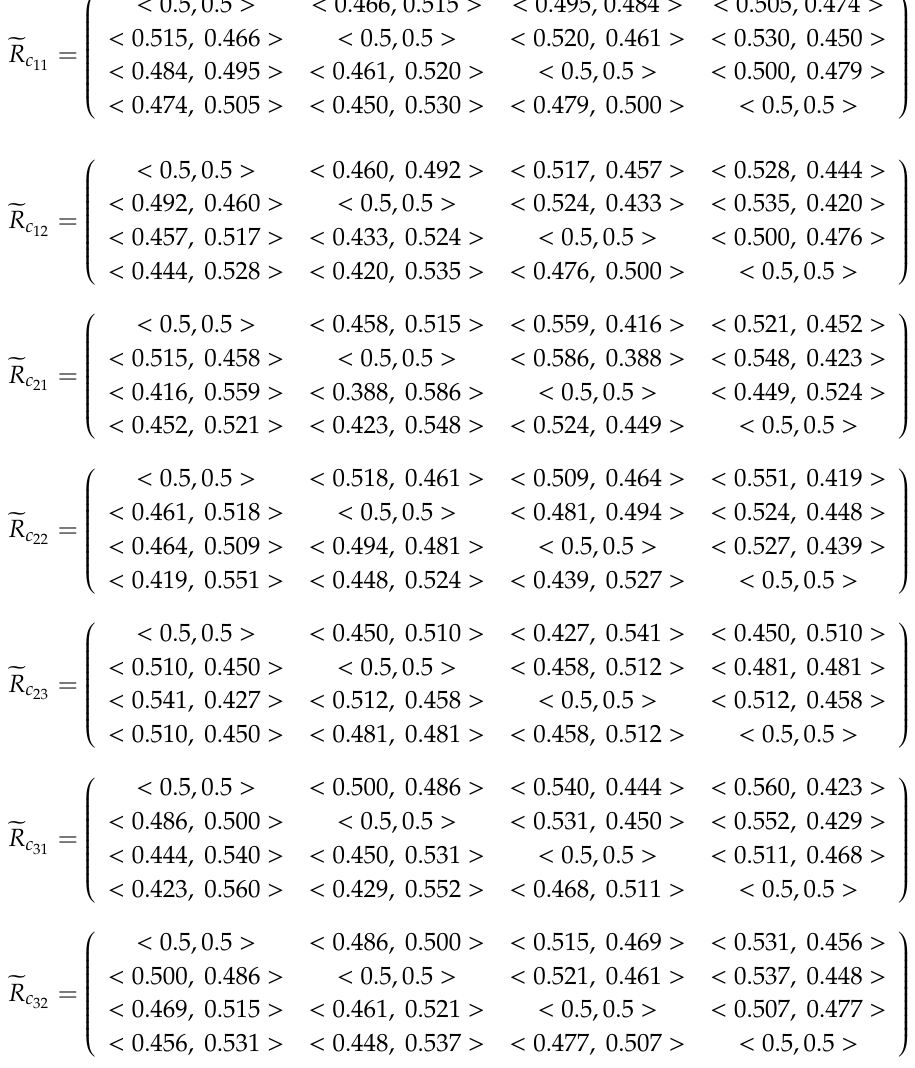
For the sub-criteria at the lowest-level, based on Table 5, using (9) and (10) generates eight IFPRs as